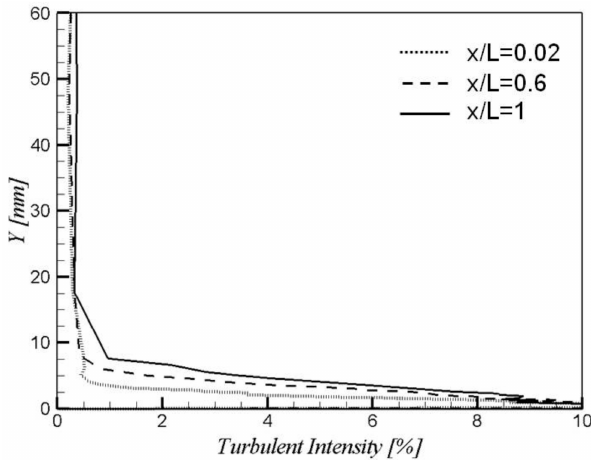
Figure 8. TI distribution of near the wall for wind velocity of 20 m / s.